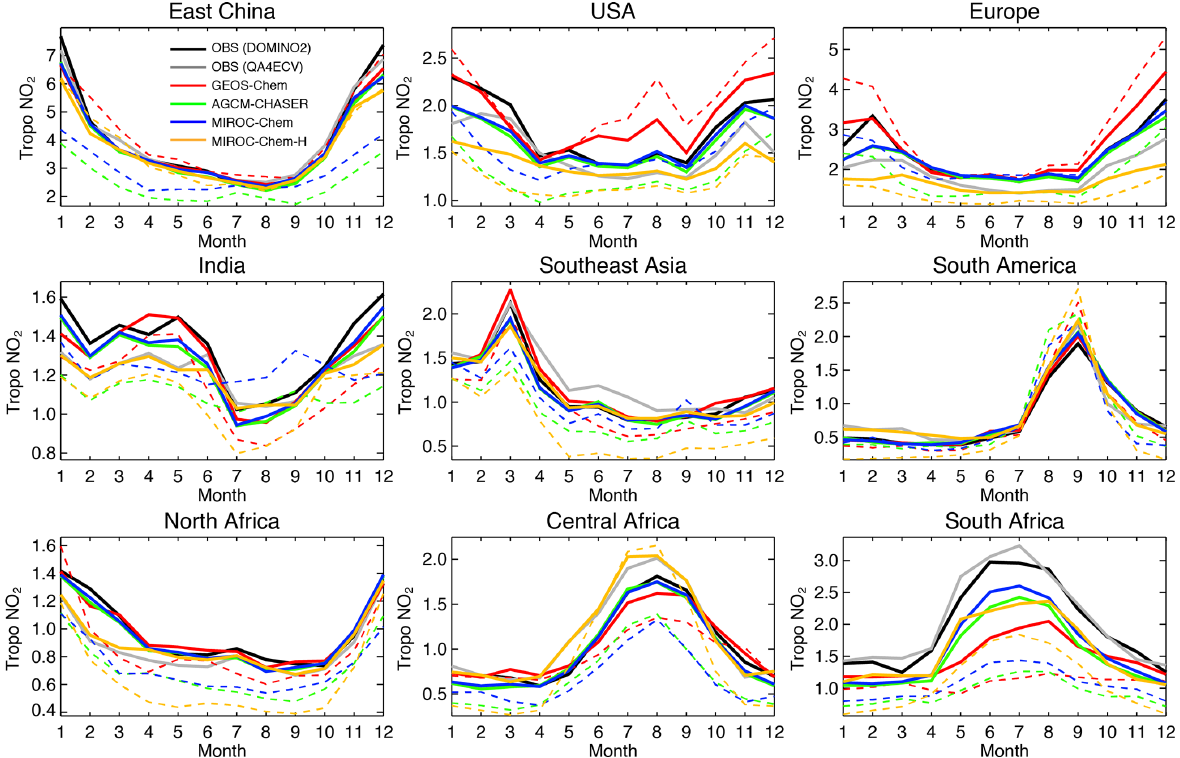
Figure 9. Time series of regional monthly mean tropospheric NO 2 columns (10 15 moleculescm − 2 ) from the satellite retrievals (black for OMI QA4ECV and gray for OMI DOMINO v2), control runs (colored dotted lines), and data assimilation analysis (colored solid lines) for 2007. The model simulation and data assimilation results are obtained at the local overpass time of the retrievals by applying the averaging kernel of OMI DOMINO v2 for GEOS-Chem, CHASER, and MIROC, and of OMI QA4ECV for MIROC-H, respectively, corresponding to the assimilated measurements. The multi-model standard deviations are not shown because of the use of different assimilated measurements in the individual